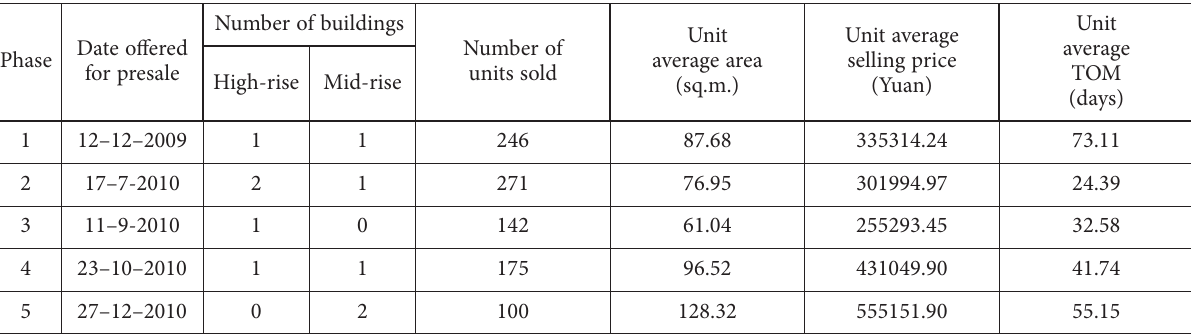
Table 3. Phase characteristics